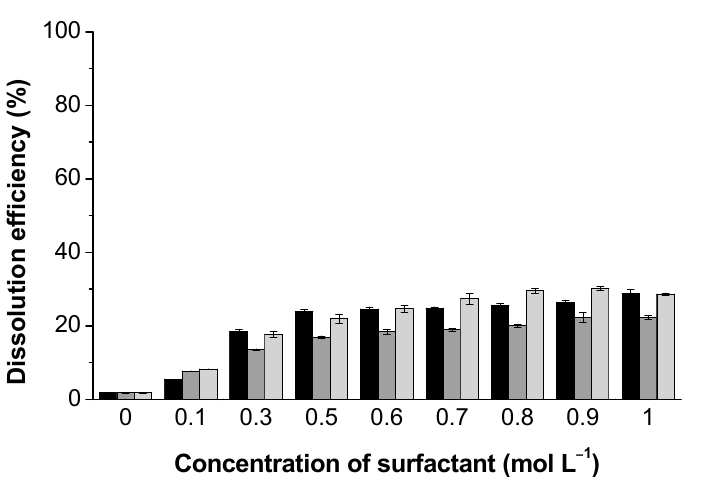
Figure 4. Dissolution efficiency of kraft lignin in water as a function of the anionic surfactants sodium octyl sulfate (SOS) (black), sodium decyl sulfate (SDeS) (gray), and sodium dodecyl sulfate (SDS) (light gray).